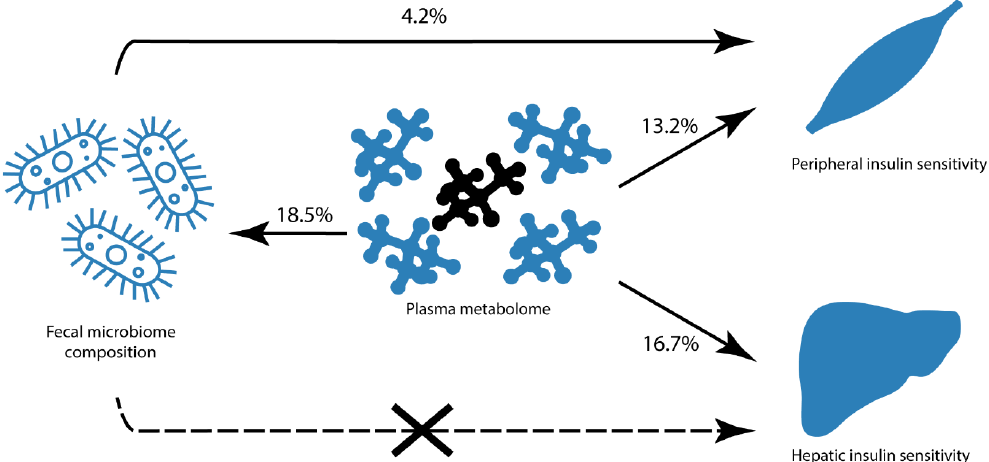
Figure 3. Graphical depiction of relationships between biological dimensions. Associations are expressed in percentage of explained variance (where at least some of the variance in the phenotype could be explained by the model). The machine learning model was able to explain a relatively high variance of hepatic insulin sensitivity (16.7%) and peripheral insulin sensitivity (13.2%). Models using gut microbiome composition (on taxonomical level) to predict insulin sensitivity only found an explained variance for peripheral IS (4.2%) and no link with hepatic insulin sensitivity. Plasma metabolites could explain 18.5% of the variance in gut microbial alpha-diversity and even 44.7% when using the top 20 metabolites.